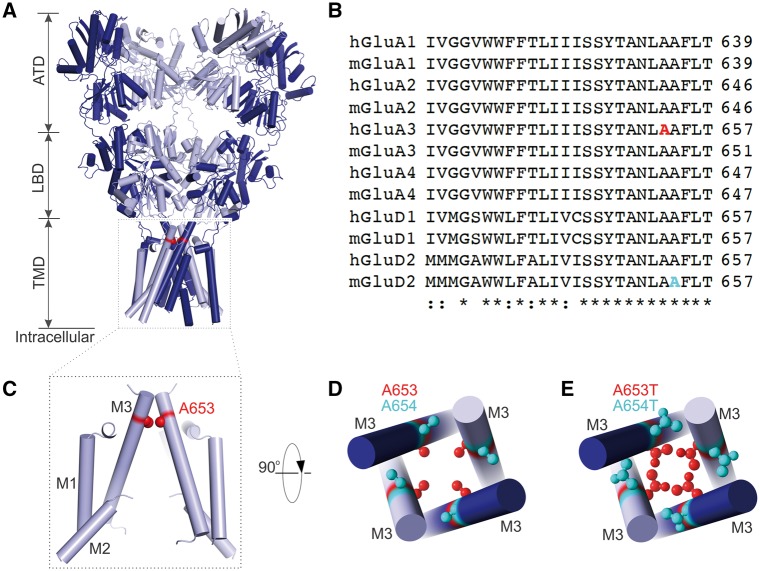
The A653T GRIA3 mutation relative to the Lurcher mutation. (A) Structure of a prototypical AMPAR, specifically a GluA2 homotetramer (PDB ID 3KG2) (66). Pore proximal and pore distal subunits are colored in dark and light blue respectively. The layered AMPAR architecture consists of the extracellular amino-terminal domain (ATD) and the ligand binding domain (LBD), followed by the trans-membrane domain (TMD) and intracellular “tails”, disordered and not present in the structure. Residue A621 (3KG2 numbering), equivalent to A653 in GluA3, is colored in red (side chain atoms shown as spheres). (B) Sequence alignment of transmembrane helix III (M3) from different human (h) and mouse (m) glutamate receptor proteins. The mutated alanine A653 (red) falls within a highly conserved transmembrane motif that lines the ion channel pore. In GluD2, encoding a different glutamate receptor subunit, the neighbouring alanine residue (cyan) is mutated to threonine in the Lurcher mouse (A654T). (C) Side view of the four-fold symmetric channel pore, with A653 indicated in red. For clarity, two subunits have been removed. (D) Top view of the channel gate, with A653 in red and A654 in cyan. (E) Top view of the channel gate, with threonine residues modelled at the alanine sites, to illustrate the potential steric impact of the mutations. While A654T points towards a neighboring subunit, favoring pore opening, A653T leads to pore occlusion.